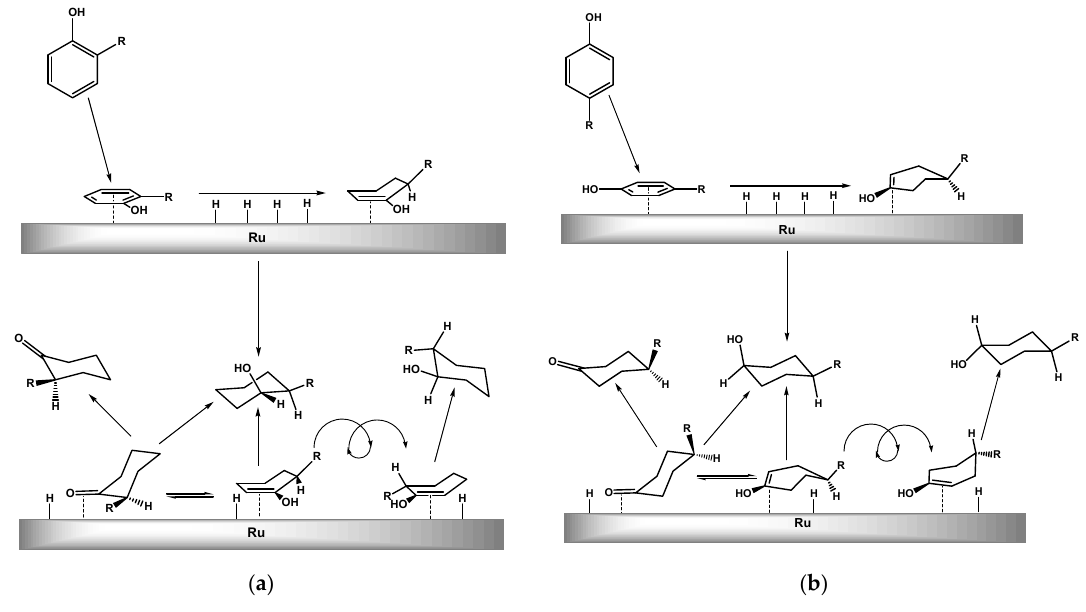
Figure 8. Possible ways for cis - and trans -product formation from ortho - and para -alkyl-substituted phenols. ( a ) ortho -isomers, ( b ) para -isomers.